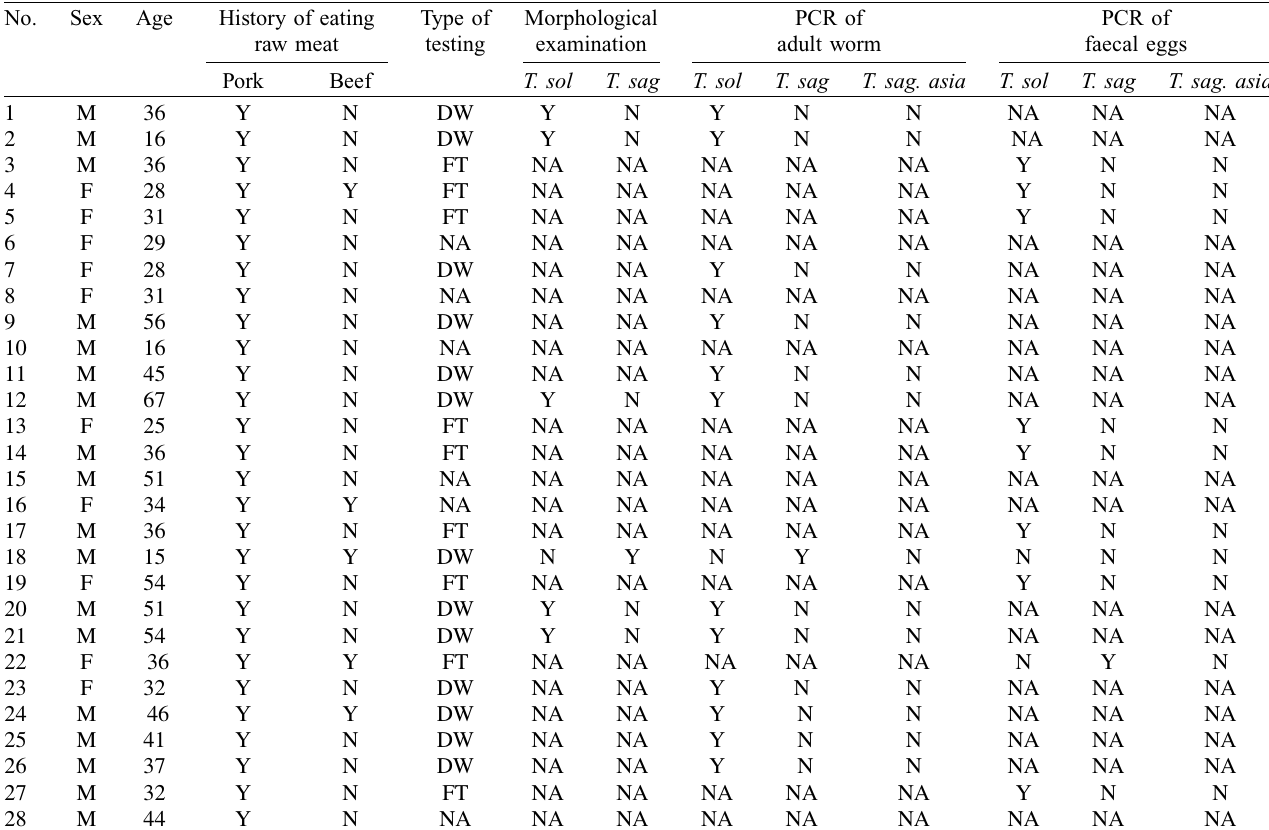
Table 3. Pro fi les of 28 Taenia carriers.